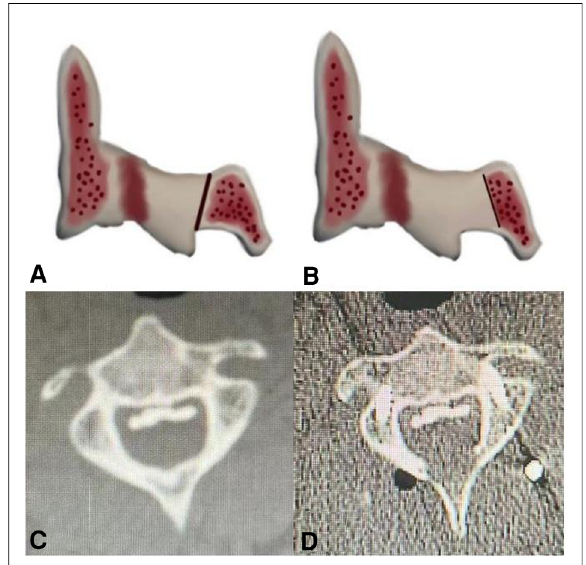
FIGURE 1 Schematic diagram of C2 dome-like laminectomy (C2-DOM). ( A,B ) The ossi fi cation of the posterior longitudinal ligament (OPLL) up to C2. ( C,D ) The C2 after dome-like laminectomy. (the ligamentum fl avum and the ventral part of the lamina were